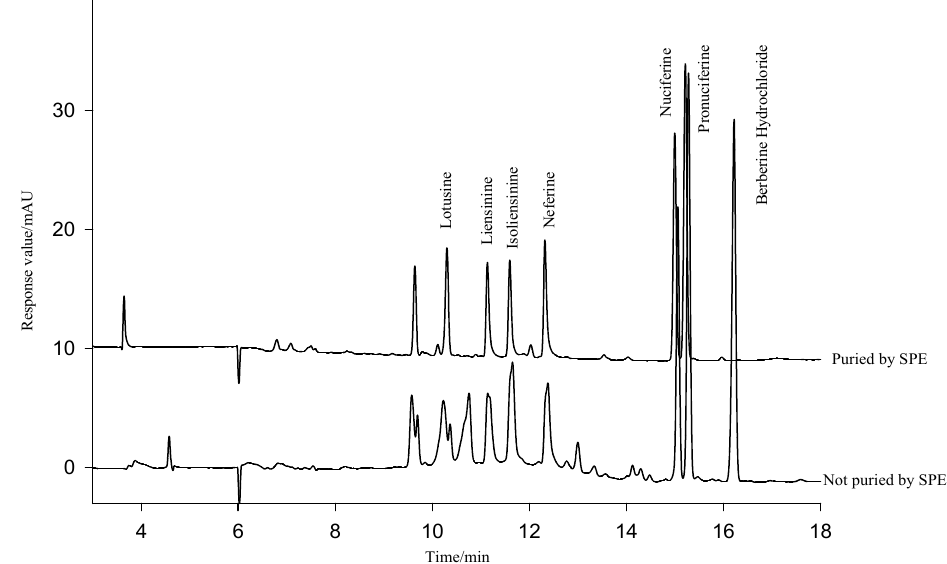
Figure 4. Chromatograms of purified and not purified by SPE.